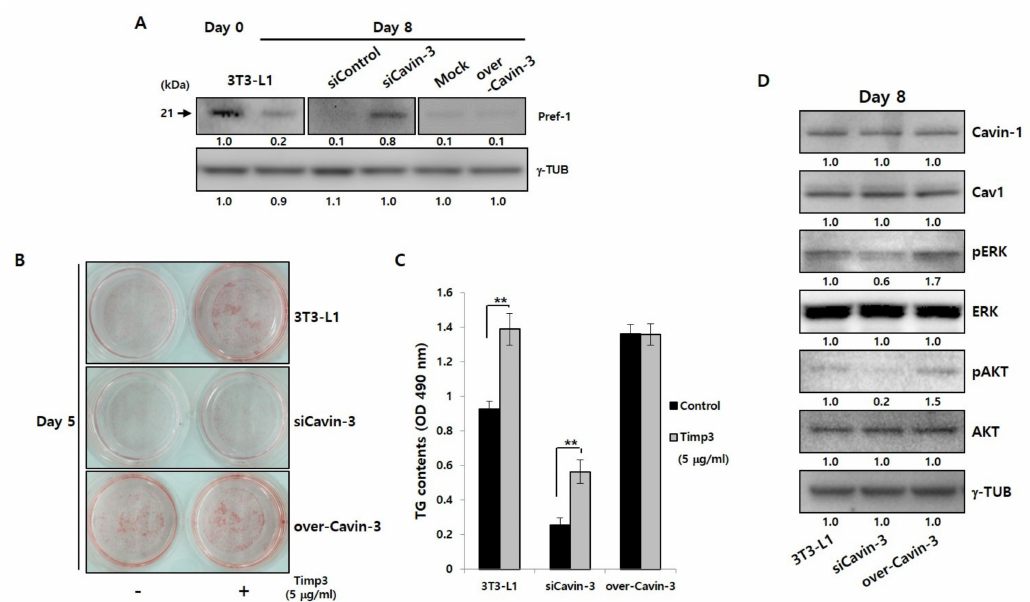
Figure 3. Cavin-3 gene modulation influences the Pref-1 shedding process, but not the caveolae group. ( A ) Western blot analysis of Pref-1 protein expression in normal 3T3-L1 adipocytes, siControl, siCavin-3, Mock, and over-Cavin-3 cells using specific Pref-1 antibody. Total protein was prepared before and 8 days after adipogenesis induction. γ -TUB was used as a control. ( B ) The e ff ect of TACE activity blocking agent, timp3, a ff ect adipocyte di ff erentiation in normal 3T3-L1 adipocytes, siCavin-3, and over-Cavin-3 cells after 5 days of di ff erentiation and analyzed by ORO staining. ( C ) The TG content of normal 3T3-L1, siCavin-3, and over-Cavin-3 cells after 5 days of di ff erentiation with or without timp3 treatment. The intracellular TG content of cells in 6-well plates was measured ( n = 3). The data are presented as the means ± SD. (* p < 0.05, ** p < 0.01; data were analyzed with unpaired Student’s t -test). ( D ) Caveolae group and related signaling protein levels were determined by Western blot analysis using specific antibodies. Total protein was prepared at day 8 after adipogenesis induction. γ -TUB was used as a control and the grouping of blots cropped from di ff erent